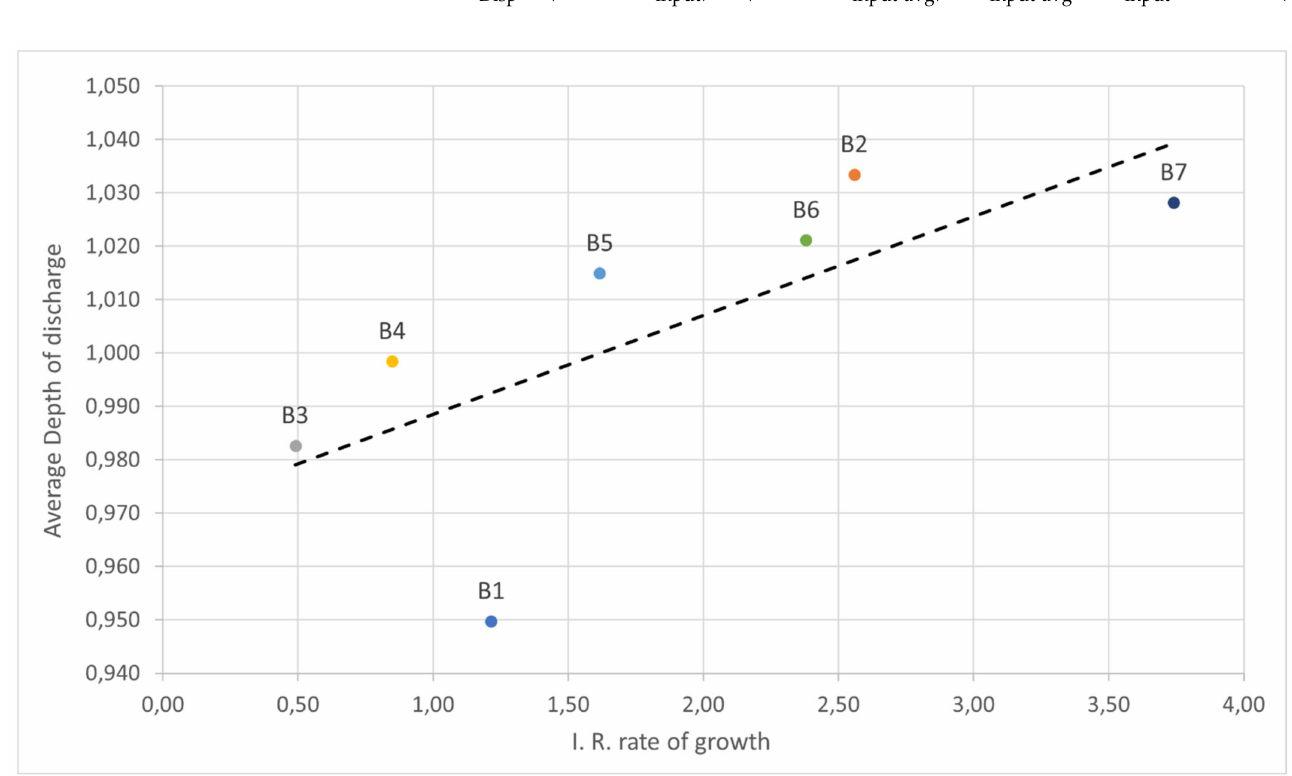
Figure 7. Depth of discharge vs. internal resistance